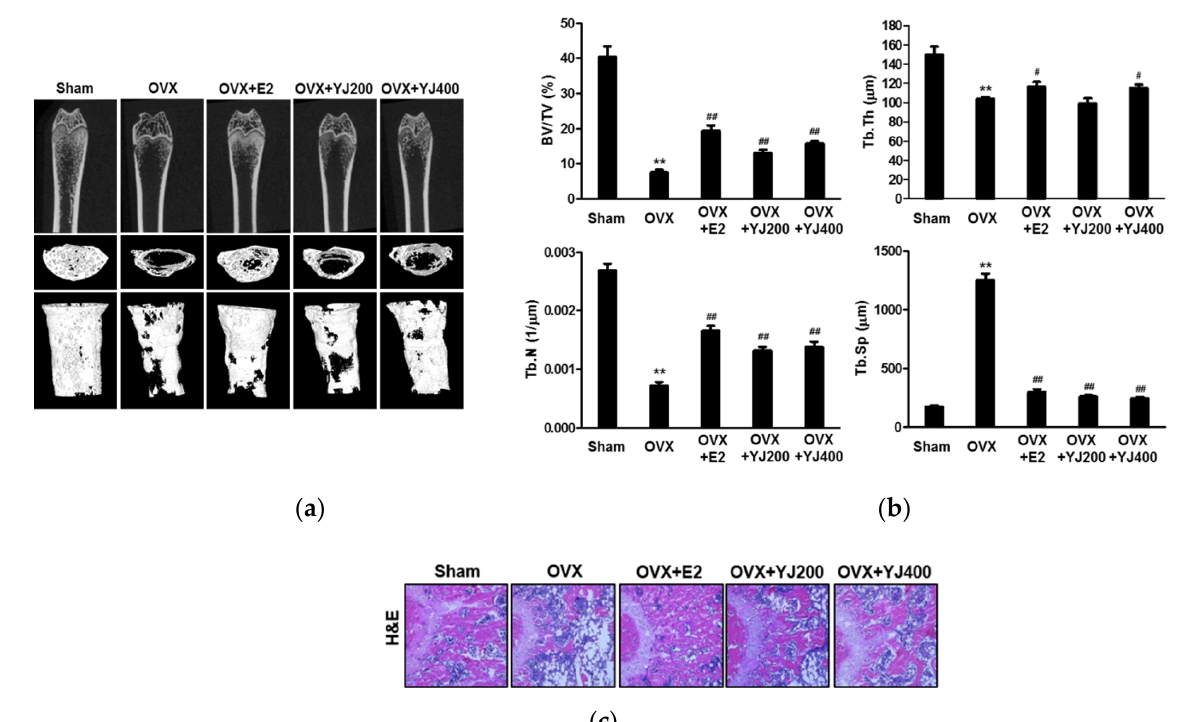
Figure 8. YJ prevented OVX-mediated bone loss. Nine-week-old SD rats were ovariectomized, and one week later, YJ (200 and 400 mg/kg) or PBS was administered orally once a day for 12 weeks. All rats were sacrificed with diethyl ether inhalation at 12 weeks. ( a ) Representative 3D reconstruction images of femurs from micro-CT. ( b ) The BV/TV, Tb.Sp, Tb.Th, and Tb.N were quantified at the left femur. ( c ) Dissected femora were fixed, decalcified, embedded in paraffin, and sectioned. Sections were stained with hematoxylin and eosin (H&E). ** p < 0.01 versus SH group; # p < 0.05, ## p < 0.01 versus the OVX group ( n = 6).